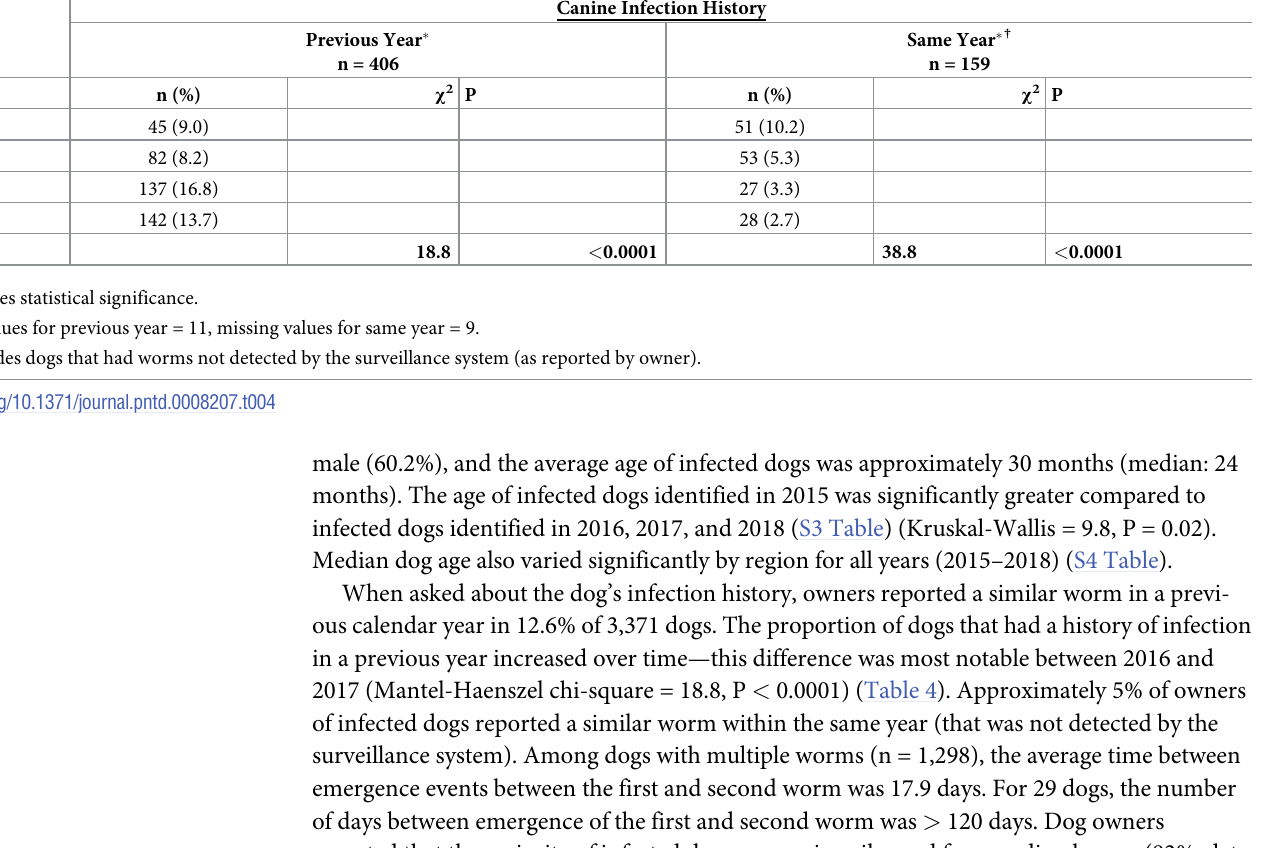
Table 4. Owner-reported history of previous Guinea worm-like illness in dogs infected with Dracunculus medinensis in Chad, 2015–2018.